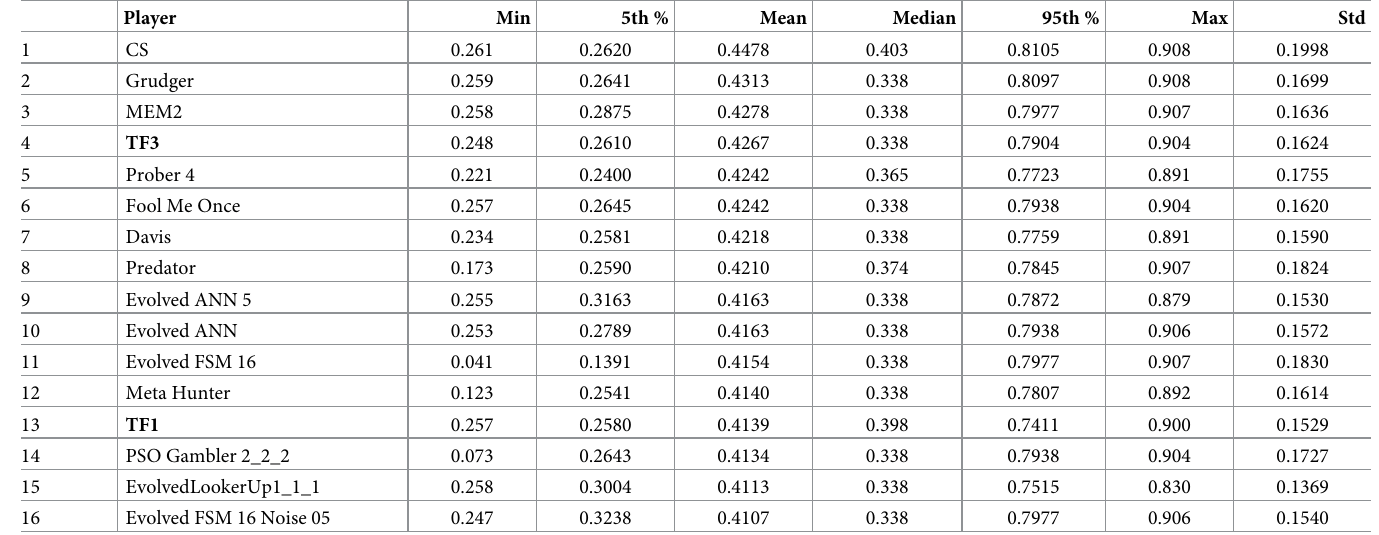
Table 5. Top invaders for N = 3.